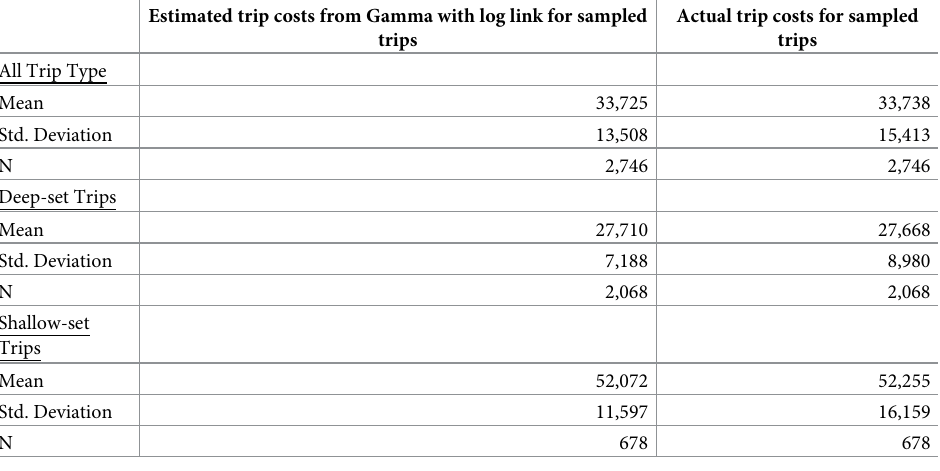
Table 8. Estimated and actual trip costs for sampled trips in Hawaii longline fishery.